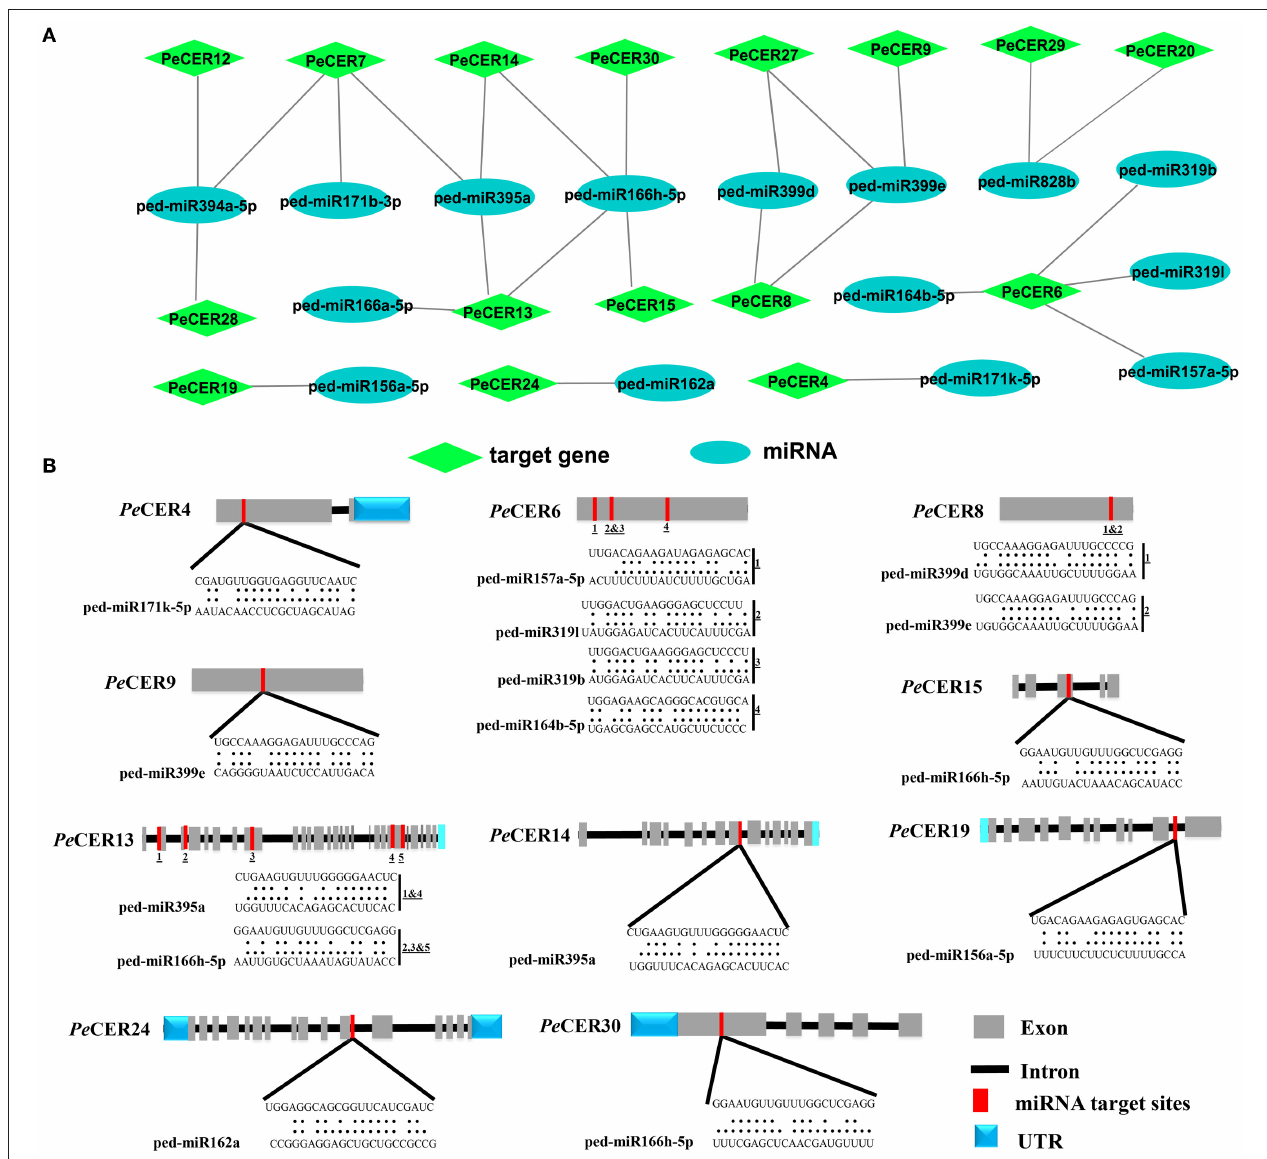
FIGURE 6 | Predicted miRNA targeting PeCER s genes. (A) Network illustration of predicted miRNA targeting PeCER genes. Green hexagon colors represent PeCER genes, and bluish ellipse shapes represent miRNAs. (B) The schematic diagram indicates the PeCER genes targeted by